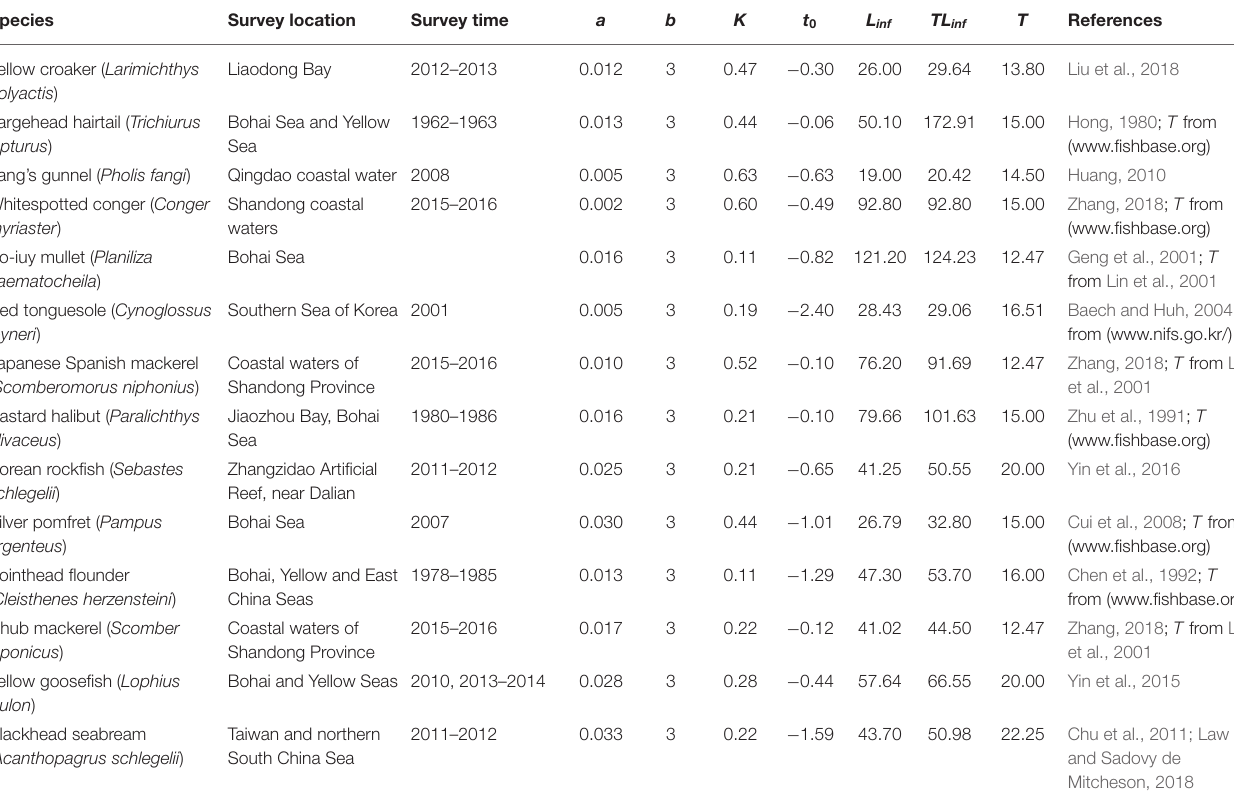
TABLE 1 | Parameters used for assessing 14 species in China’s coastal seas ( a refers to weight in g; K in year − 1 ; L inf and TL inf in cm; T in ◦